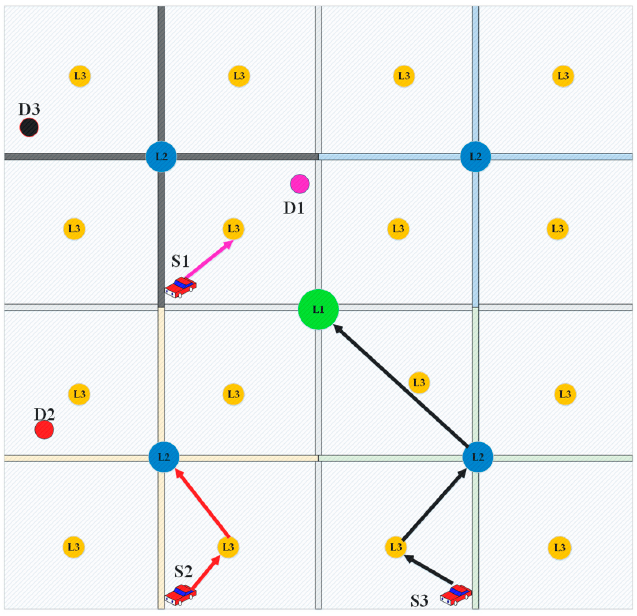
Figure 3. Path request process.